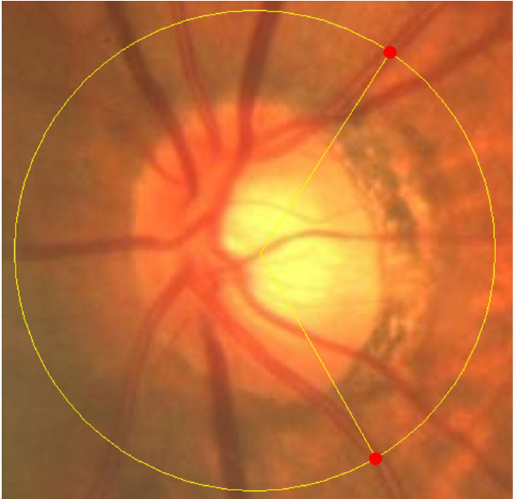
Figure 1. Measurement of peripapillary retinal arteries angle (PRAA) (left eye). The PRAA was calculated as the angle between the radia crossing the points (red dots) at the intersection between the 3.4 mm-diameter peripapillary scan circle (yellow) and the supratemporal/infratemporal major retinal arteries. The right eye was mirror-imaged.